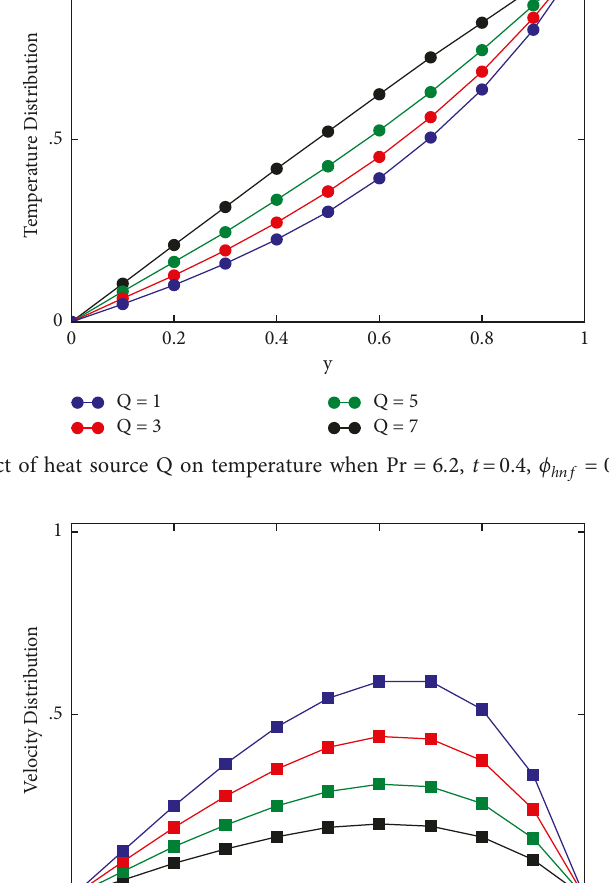
. 2, t 0.1, M (cid:30)